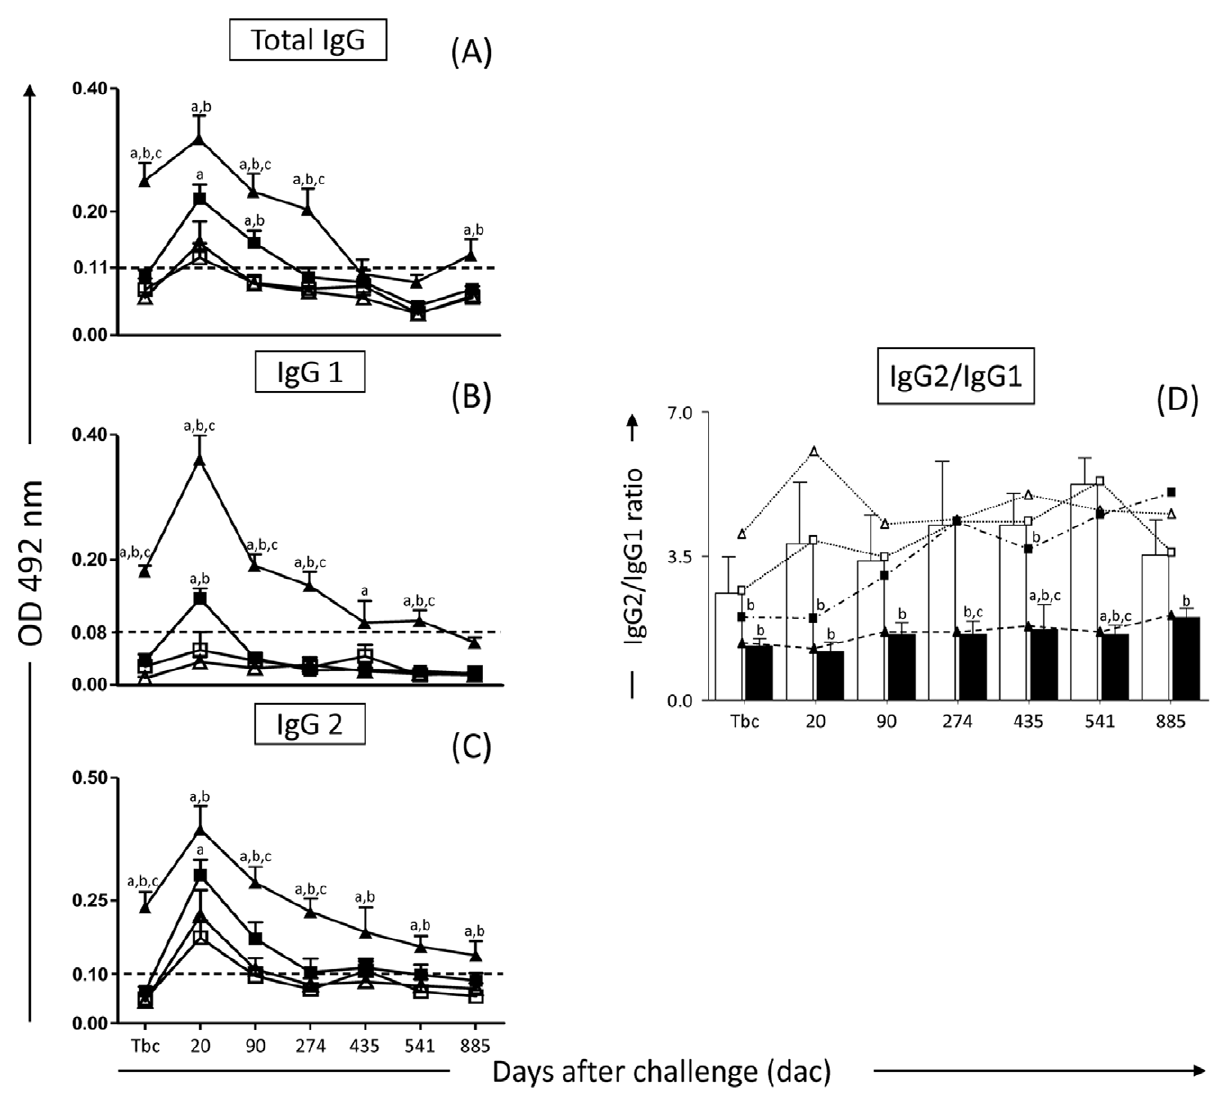
Figure 1. Anti- Leishmania reactivity in serum from dogs submitted to different vaccination protocols before and after intradermal challenge with L.infantum plus SGE: C (control; white square); Sap (saponin; white triangle); LB (killed L.braziliensis vaccine; black square); LBSap (killed L.braziliensis vaccine plus saponin; black triangle). IgG2/IgG1 ratio: C (control; white square) and LBSap (killed L. braziliensis vaccine plus saponin; black square). Figure 1A represents anti- L. infantum total IgG, (B) anti- L. infantum IgG1, (C) anti- L. infantum IgG2 and (D) IgG2/IgG1 ratio: the x -axis displays the times at which the assays were conducted (Tbc: time before challenge with L . infantum ; and 20, 90 274, 435, 541 and 885 days after challenge [dac] with L . infantum ), and the y -axis represents the mean ELISA absorbance values determined at 492 nm in serum samples diluted 1:80 for IgG total and subclasses. The cut-off is represented by the dotted line. Significant differences ( p , 0.05) between the LBSap group and the control C, Sap and LB groups are indicated, respectively, by the letters a, b, and